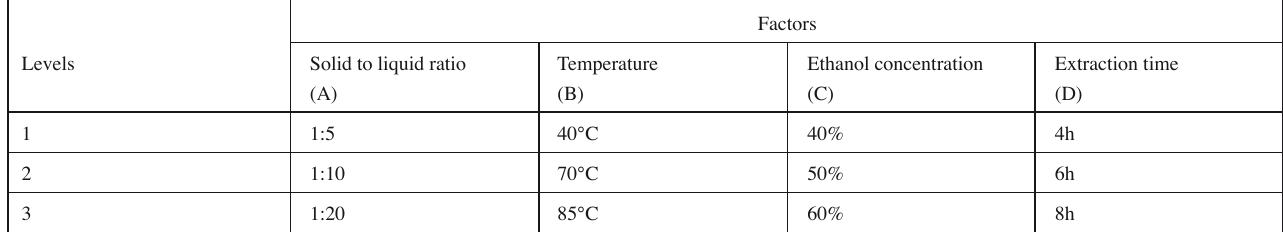
Tab. 2: Factors and levels of orthogonal experiment of N . obtusa